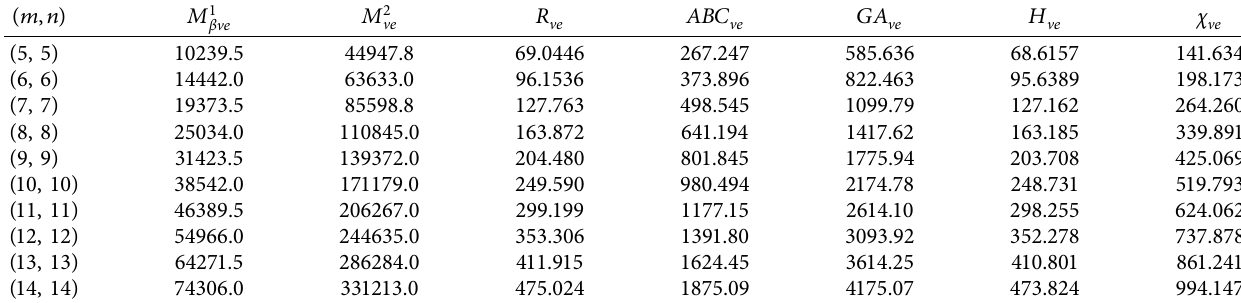
, M 2 ve , H ve , R ve , χ ve , ABC ve , GA ve for Y -junction graph Y 2 m ( n, n ) . β ve